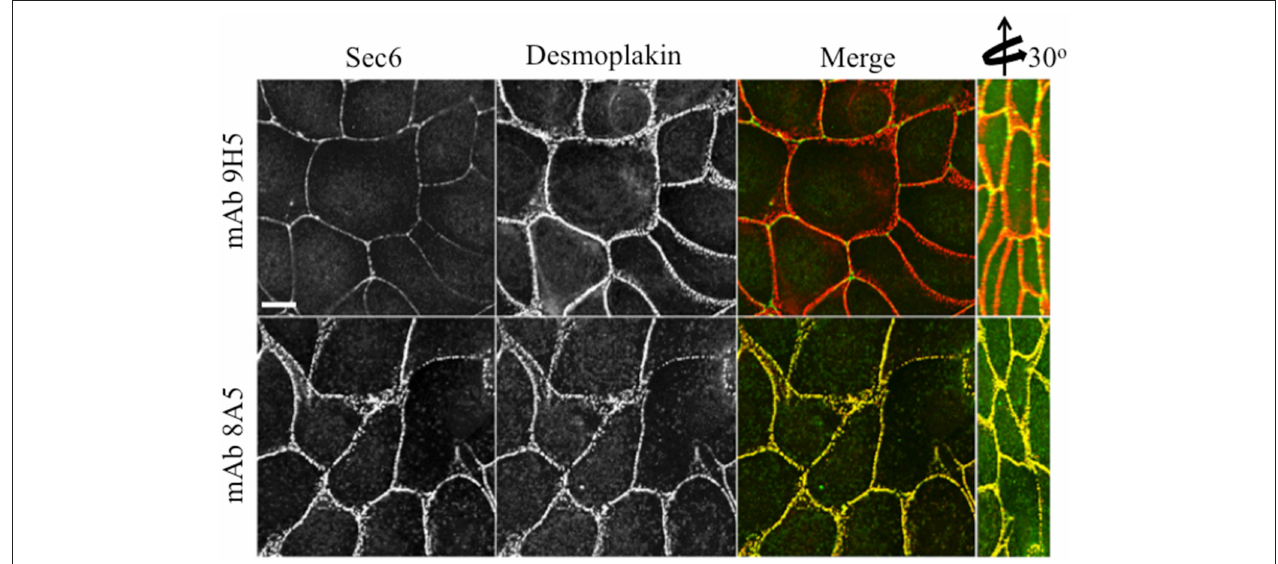
FIGURE 5 | Immunologically distinct pools of Sec6 are localized at AJC and desmosomes. MDCK cells were fixed and labeled with indicated antibodies to Sec6 (green) and the desmosome component, desmoplakin (red). Note that mAb 8A5 detects a pool of Sec6 that co-localizes with desmoplakin. In contrast, mAb 9H5 detects a pool of Sec6 that does not co-localize with desmosome proteins. Bar = 10 µ m.